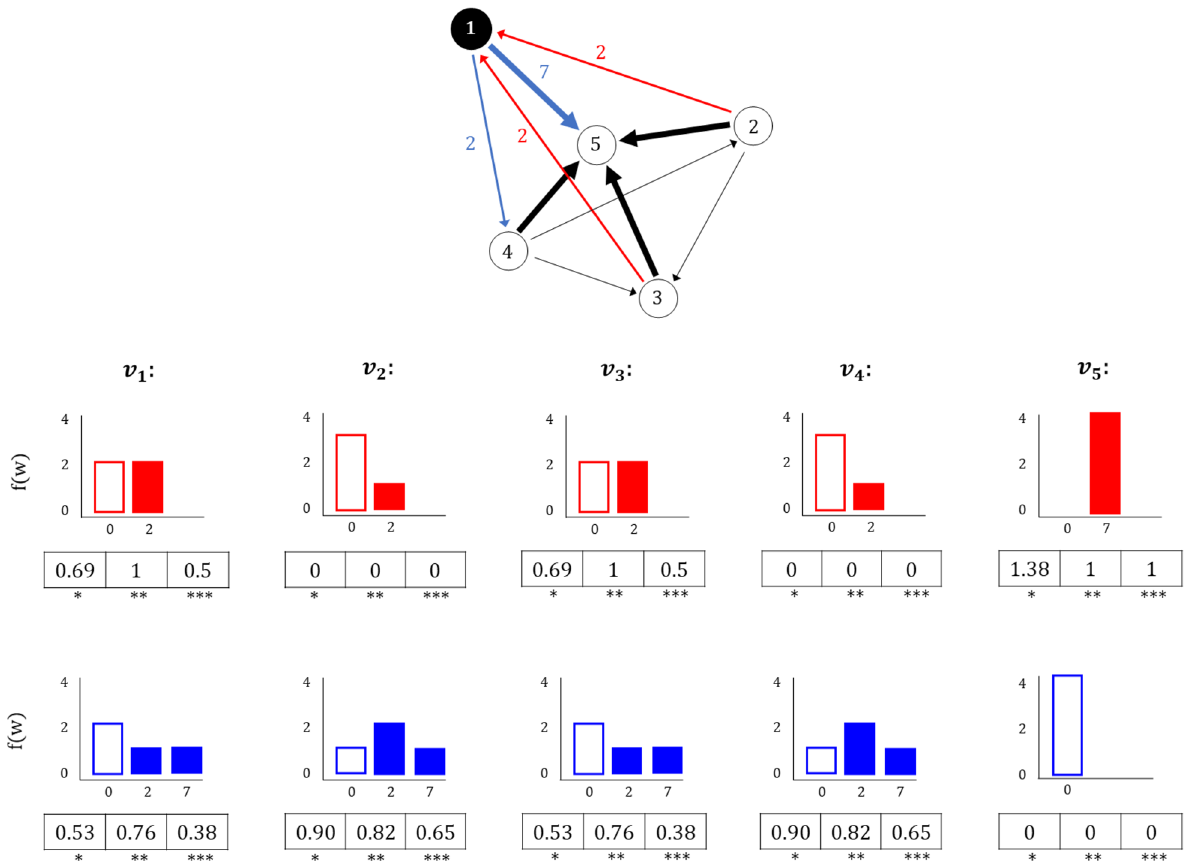
Figure 3. Local node entropy. A commuting network where the sub-graph at node v 1 is highlighted with in-flows in red, and out-flows in blue.The network consists of nodes with different degree and link weight distributions to explore the different results and normalisation approaches. Diagrams for in-flows frequency distribution f ( w ) at every node are in red, and out-commuting f ( w ) are in blue. Entropy and normalised values corresponds to: (*) = H in L , (**) = H in L / H in deg or H out L / H out deg , and (***) = H in L / H Mpd or H out L / H Mpd . As an example, a uniform distribution of in-flows and a deg in = 2 on v 1 results in a maximum 1 for (**) and 0.5 for (***), whereas a uniform weight distribution and a maximum possible deg in = 4 of node v 5 results in a maximum 1 for (**) and